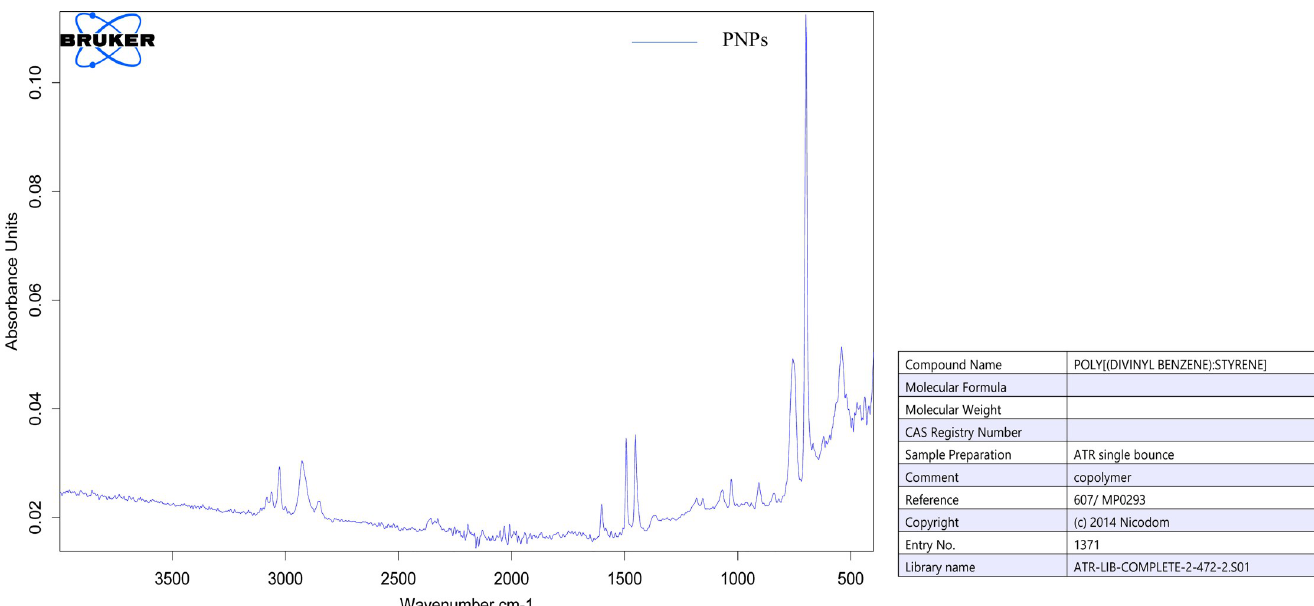
Fig 3. The Fourier Transformed Infrared Spectroscopy (FTIR) of polystyrene nanoparticles. Sample Spectrum and relative characteristics table.